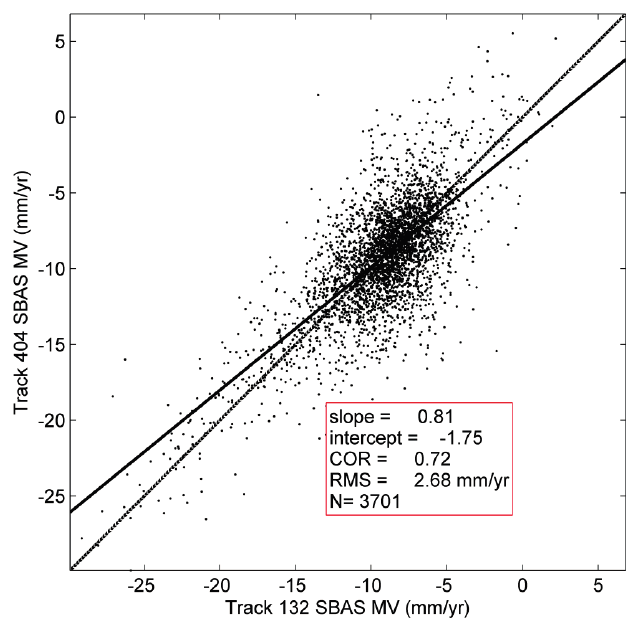
Figure 4. Correlation between line of sight displacement rates estimated from time series of the two tracks. Scatter plot showing all pixels common to both tracks 404 and 132. Best-fit line is shown (solid line) along with the 1:1 line (dashed). The RMS of the residuals from the best-fit line is 2.68